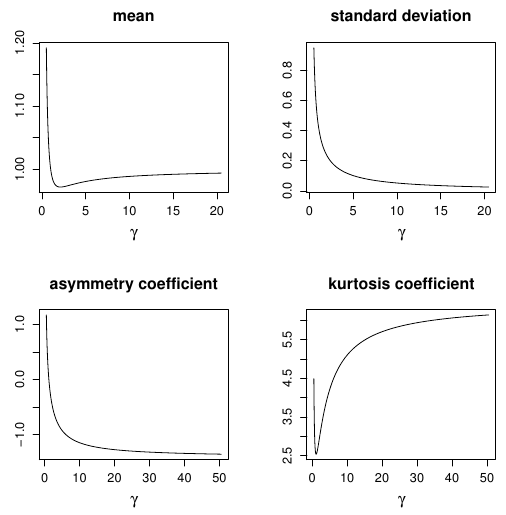
Figure 2. Mean, standard deviation, asymmetry and kurtosis as functions of γ ( β =